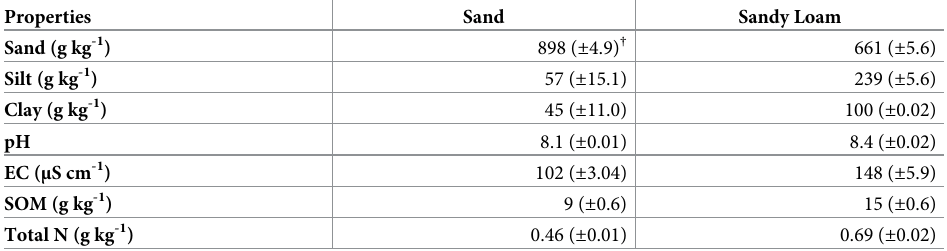
Table 1. Basic properties of soil used in the laboratory incubation study conducted at the Aberdeen Research and Extension Center, Aberdeen, ID, USA.